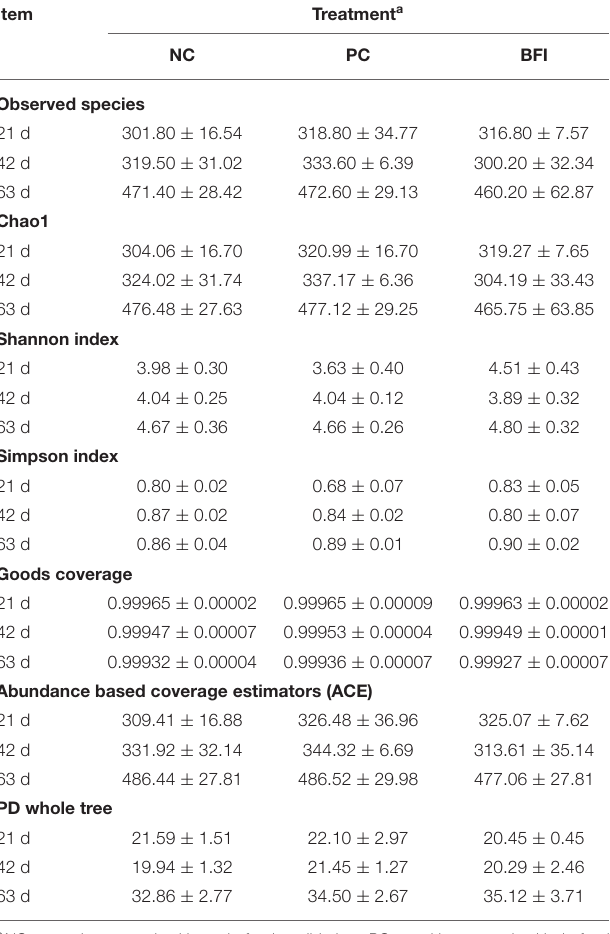
TABLE 5 | Effect of dietary supplementation with heat-inactivated compound probiotics on the α -diversity in yellow-feathered